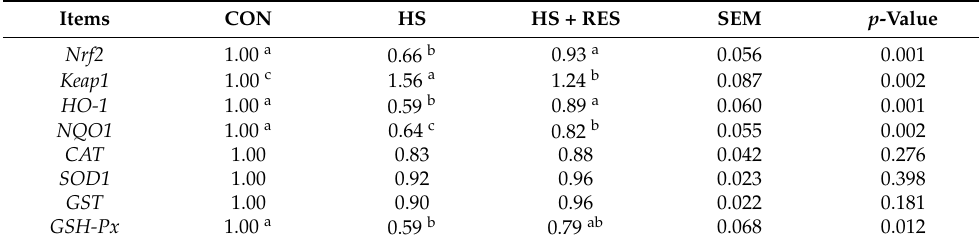
Table 5. Effects of RES on antioxidant-related gene levels in the skeletal muscle of heat-stressed